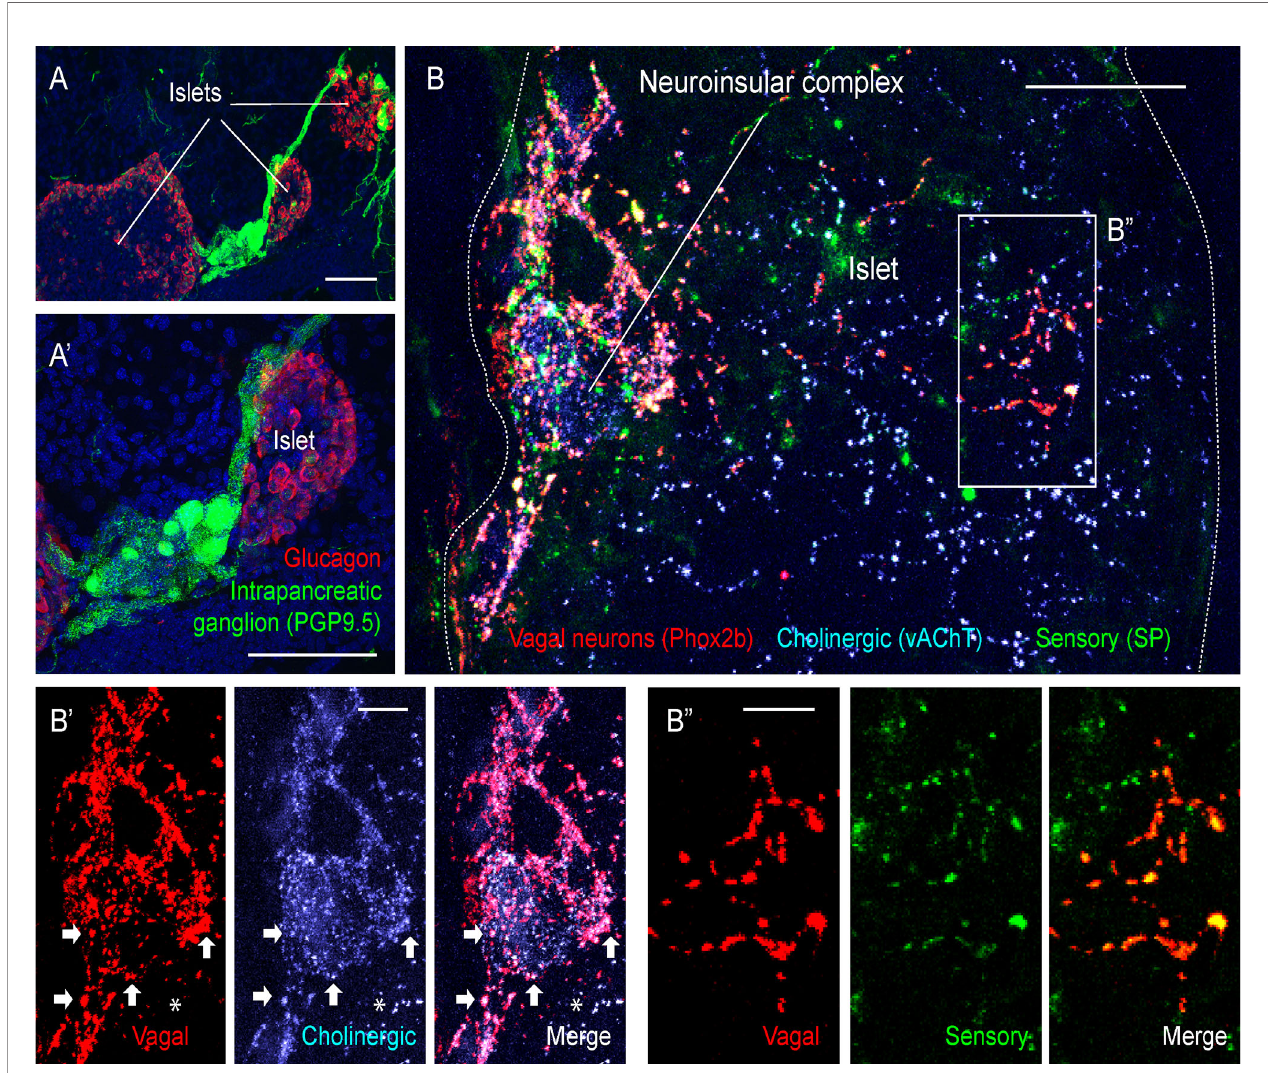
FIGURE 2 | Extrinsic and intrinsic cholinergic innervation of the endocrine pancreas ( fi gure adapted and modi fi ed from Supplementary Figures 4, 5 in Makhmutova et al, 2020). (A, A ’ ) Mouse pancreatic section immunostained for the pan-neuronal marker PGP9.5 (green) and glucagon (red); scale bar 50 µm. (B, B ’’ ) Pancreatic section of a Phox2b-Cre-tdTomato fl oxed transgenic mouse, immunostained for red fl uorescent protein (red), the sensory neuronal marker substance P (SP, green), and the cholinergic neuronal marker vesicular acetylcholine transporter (vAChT, blue). Inside the neuroinsular ganglion, Phox2b-positive varicosities colocalize with vAChT ( B ’ , arrows ), indicating terminals of vagal preganglionic neurons; scale bar 20 µm. Outside of the neuroinsular ganglion (inside the islet), Phox2b-positive fi bers colocalize with SP (B ” ) but not with vAChT ( B ’ , asterisks ), indicating vagal origin of sensory fi bers and non-vagal origin of intrinsic cholinergic fi bers; scale bar 5